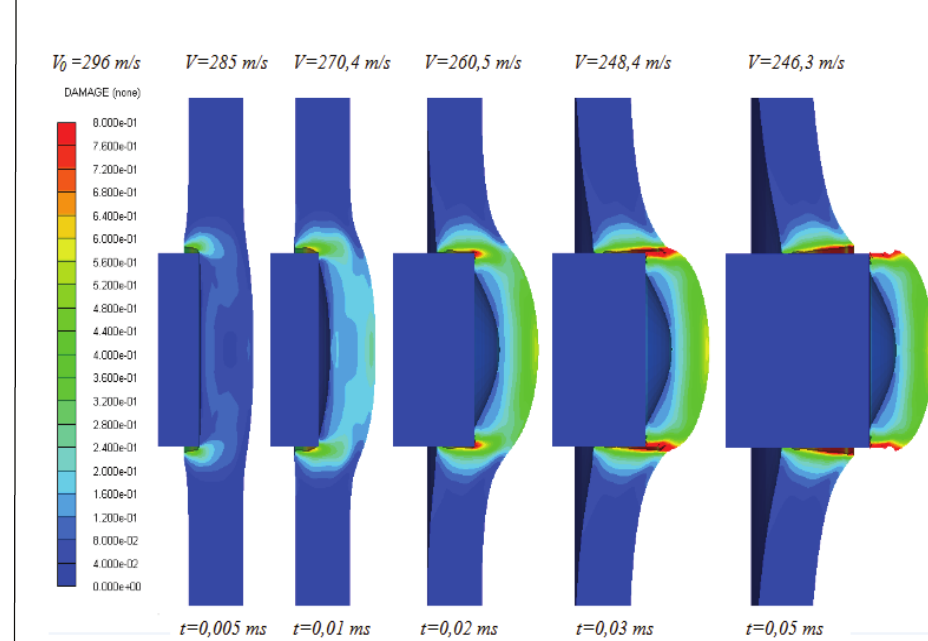
Figure 21 – Analysis of damage caused by the change of speed in the breakdown of the steel plate by a blunt projectile (FEM